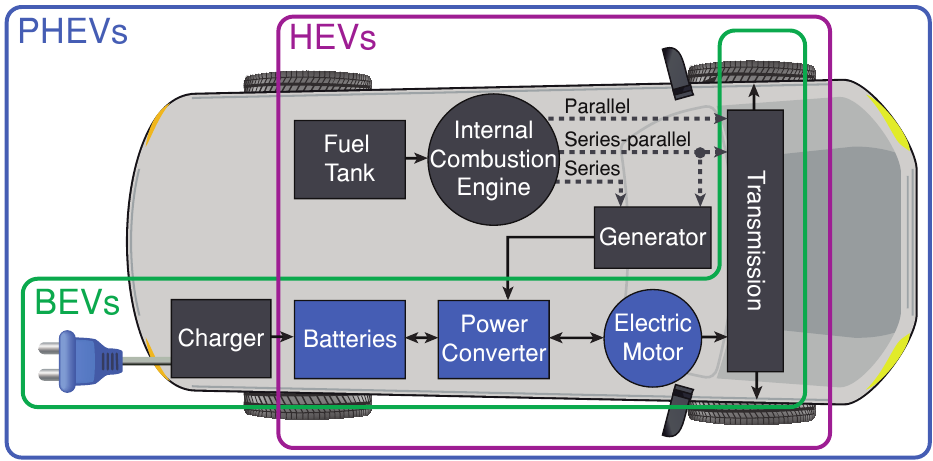
Figure 1. EVs powertrain configurations: hybrid electric vehicles (HEVs), plug-in hybrid electric vehicles (PHEVs) and battery electric vehicles